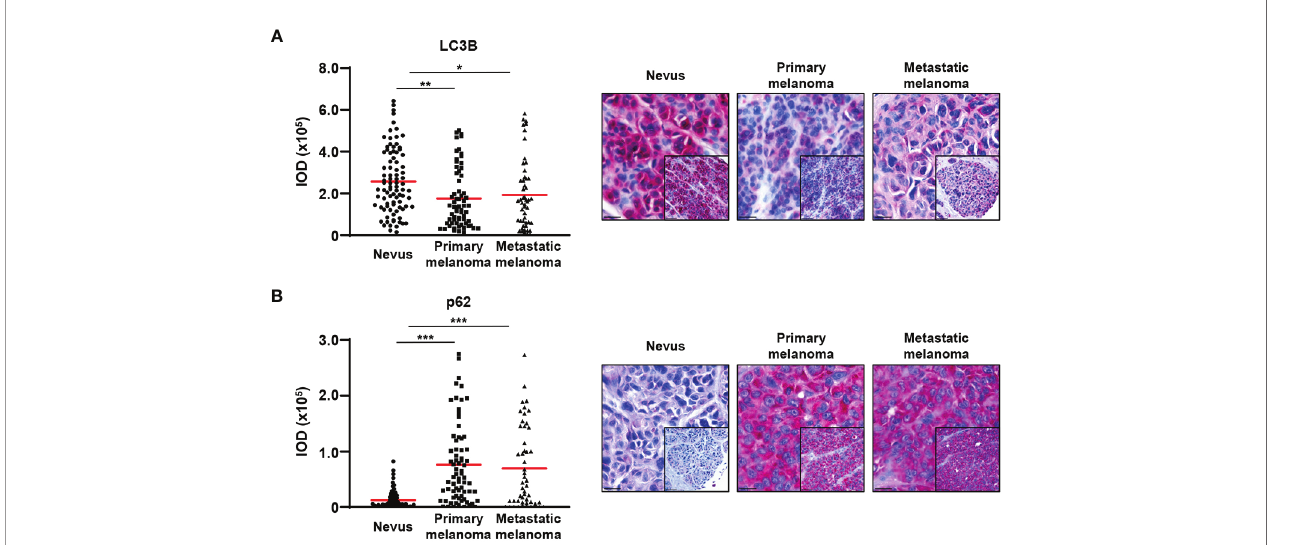
FIGURE 2 | Decreased LC3B and increased p62 expression in primary and metastatic melanomas compared with benign nevi. (A, B) Immunohistochemistry. Quanti fi cation of the LC3B and p62 signal intensity. Intensity (integrated optical density (IOD)) values for individual patients are presented. The red lines represent the mean of all values. Statistical differences were analyzed by one-way ANOVA using a Kruskal-Wallis test and Dunn ’ s post hoc test (left panel). p ≤ 0.05*; p ≤ 0.01**; p ≤ 0.001***. Representative images of 88 and 75 benign nevi as well as 72 and 67 primary and 52 and 51 metastatic melanomas are shown for LC3B and p62, respectively (right